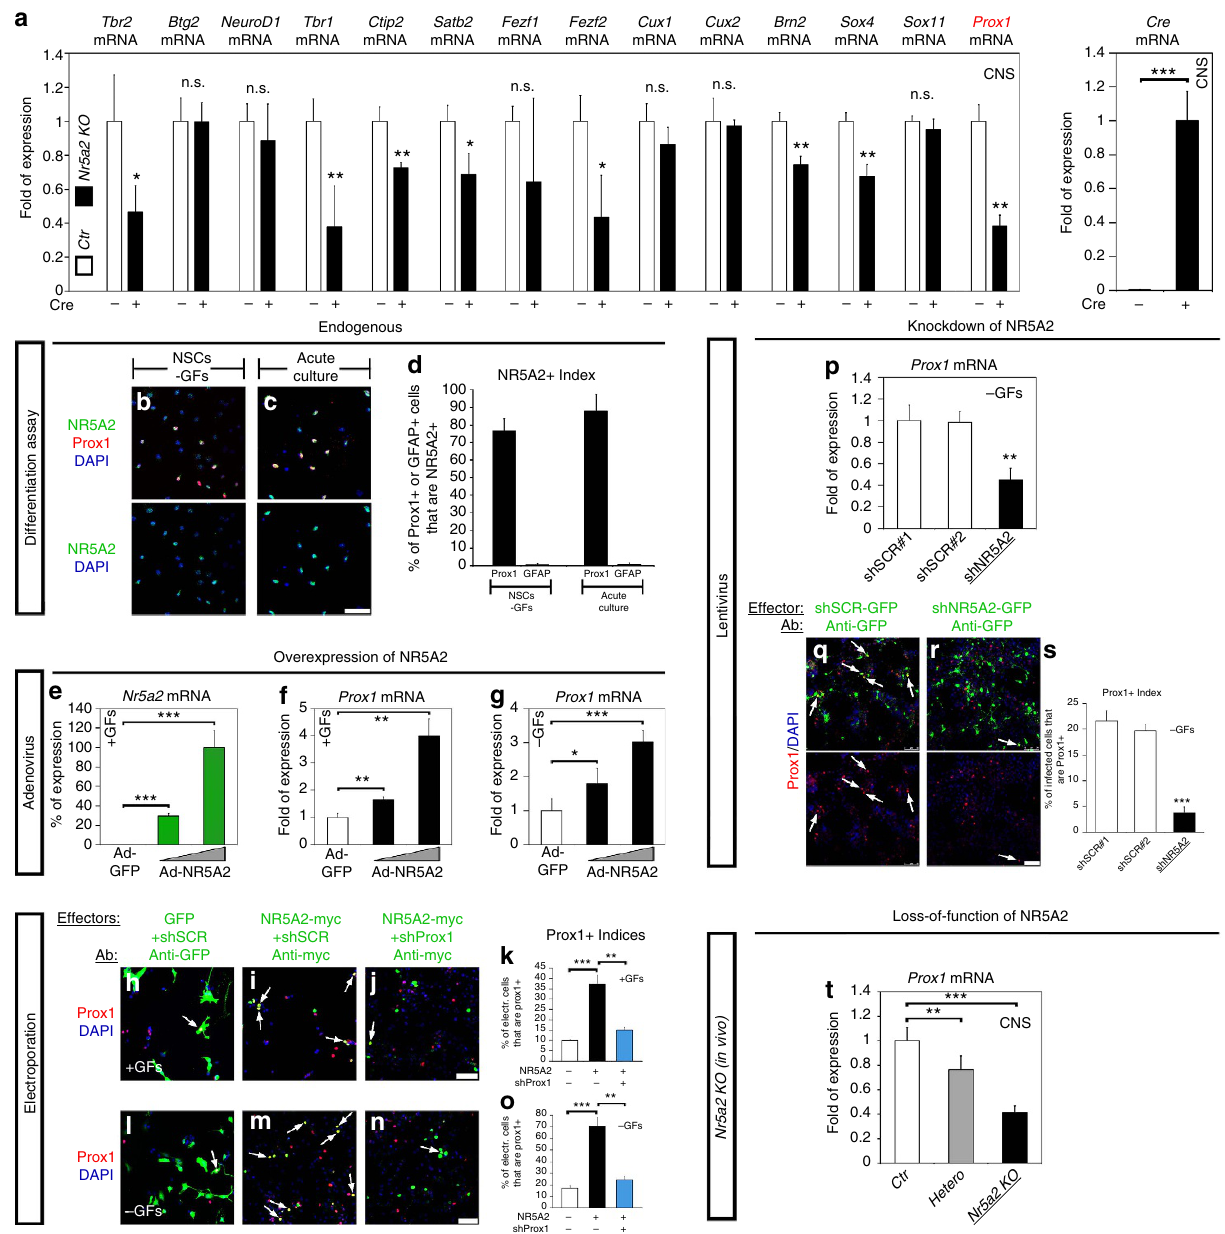
Figure 6 | NR5A2 enhances the expression of Prox1 gene. ( a ) RT–qPCR analysis in E12.5 CNS of Ctr and Nr5a2 KO animals, as indicated. Values represent the mean ± s.d. of four animals ( n ¼ 4). ( b , c ) Double immunostainings of endogenous NR5A2 (green) with Prox1 (red) in differentiating NSCs ( b ) or acute cultures of E14.5 spinal cord tissue ( c ). ( d ) Quantification of the Prox1 þ or GFAP þ cells that express NR5A2 (% of marker þ ; NR5A2 þ /total marker þ ). ( e – g ) RT–qPCRs showing the quantifications of Nr5a2 ( e ) and Prox1 ( f – g ) mRNA levels in proliferating ( e , f ) or differentiating ( g ) NSCs, infected with Ad-GFP or Ad-NR5A2 viruses. ( h – j , l – n ) Double immunostainings of GFP or myc (green) with Prox1 (red) in NSCs co-electroporated (Amaxa) with GFP þ shSCR ( h , l ), NR5A2-myc þ shSCR ( i , m ) or NR5A2-myc þ shProx1 ( j , n ) transgenes and cultured in the presence ( h – j ) or absence of GFs ( l – n ). Arrows indicate representative double positive cells. ( k , o ) Quantification of Prox1 index in þ / (cid:2) GFs, respectively. ( p – s ) RT–qPCR ( p ) and double GFP (green)/Prox1 (red) immunofluorescence analysis ( q , r ) indicating the downregulation of Prox1 mRNA and protein levels, respectively, in differentiating NSCs infected with shNR5A2 compared with shSCR lentiviruses. Arrows indicate representative double GFP þ /Prox1 þ cells. Quantification of Prox1 index is indicated in s (% of GFP þ ; Prox1 þ /total GFP þ ). ( t ) RT–qPCR quantification of Prox1 mRNA in E12.5 CNS of Ctr , Hetero and Nr5a2 KO mice. The results are shown as mean ± s.d. NS, not significant. P 4 0.05, *P o 0.05, * *P o 0.01, ** *P o 0.001 (Student’s t -test). Scale bars, 50 m Fig. 16a–e), implying that this phenotype may be due to a partially the effect on astrogliogenesis (GFAP þ functional and direct interaction between NR5A2 and (Fig. 7o–t), suggesting that Prox1 is specifically required for Prox1 proteins. This interaction is very well-documented in NR5A2 effect on inducing neuronal differentiation. In agreement, other tissues and organs 27–30 . Immunoprecipitation and double overexpression of NR5A2 together with Prox1 resulted in much higher numbers of NSC-derived post-mitotic neurons immunofluorescence experiments confirmed this interaction in than the overexpression of NR5A2 alone (Supplementary murine E12.5 CNS and NSCs (Supplementary Fig. 16f–h).